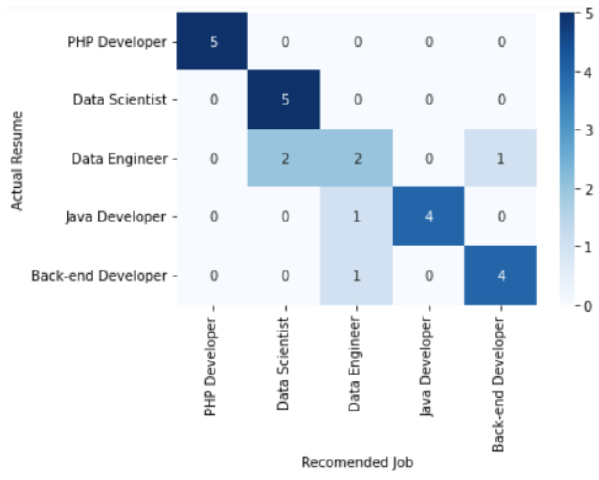
Figure 9. Confusion